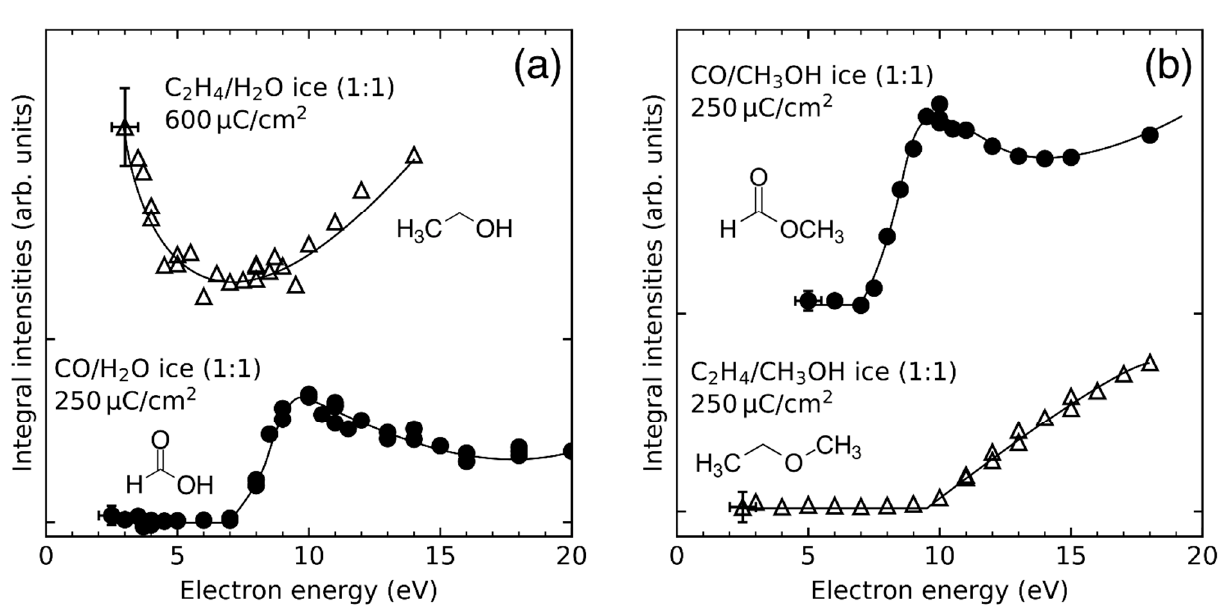
Figure 18. Dependence of the integrated desorption signals of products formed upon electron irradiation of different mixed ices as obtained by TDS after the short exposures stated in the graphs: ( a ) HCOOH in CO/H 2 O mixed ices (bottom, from Ref. [24]) and C 2 H 5 OH in C 2 H 4 /H 2 O mixed ices (top, from Ref. [28]), ( b ) CH 3 OCHO in CO/CH 3 OH mixed ices (top, from Ref. [26]) and C 2 H 5 OCH 3 in C 2 H 4 /CH 3 OH mixed ices (bottom, from Ref. [32]). The solid lines serve as a guide to the eye. A set of experiments with longer exposures at lower electron energies is presented in Figure 19. For details of the experiments see Refs. [24,26,28,32]. Adapted from Ref. [37] with kind permission of The European Physical Journal (EPJ).